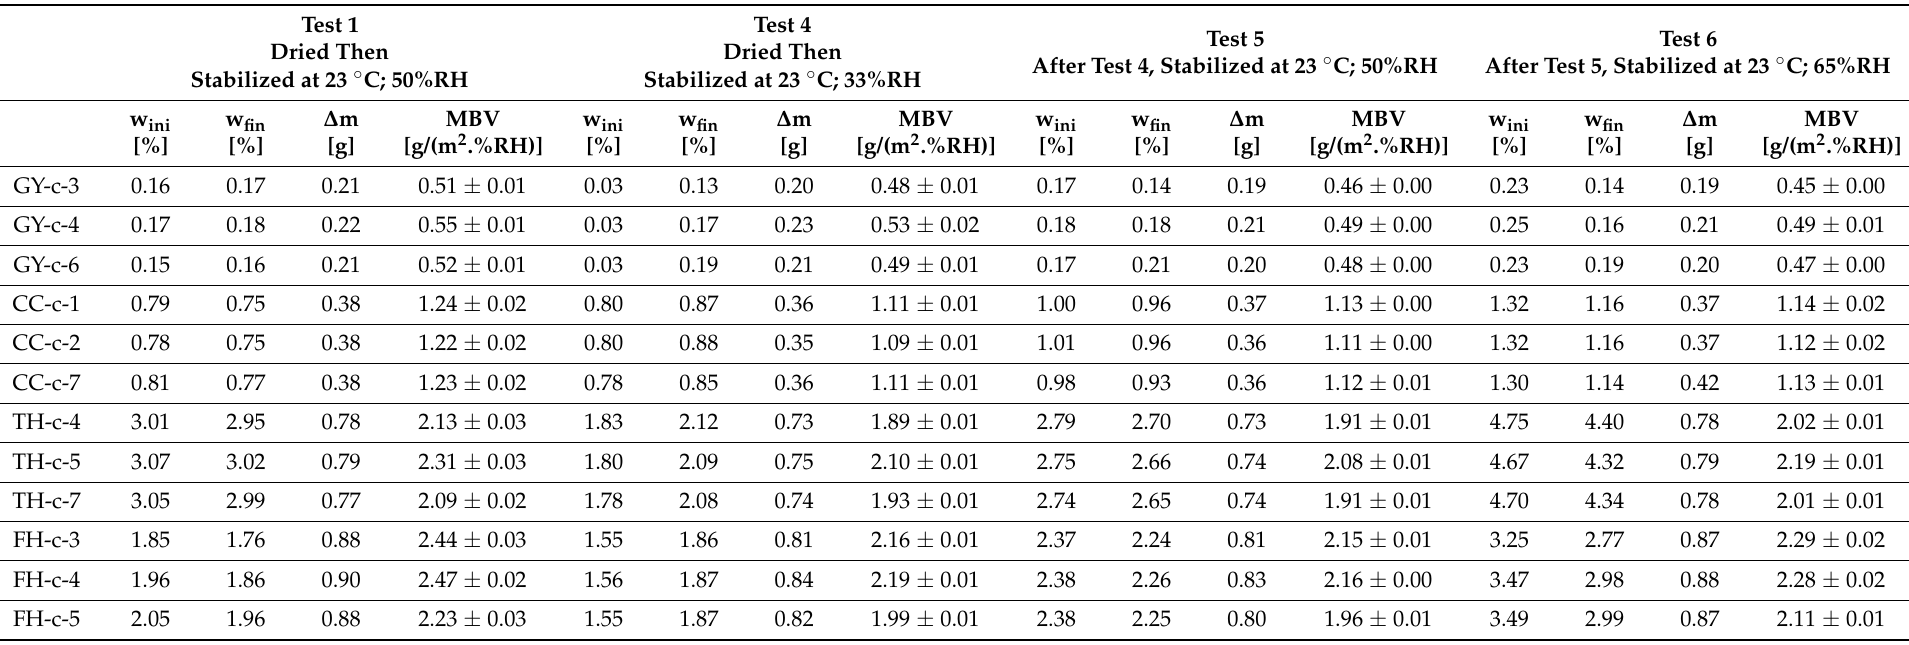
Table 9. Mass water content, w, average mass change over cycles 3 to 5, ∆ m, and MBV for the four materials under different